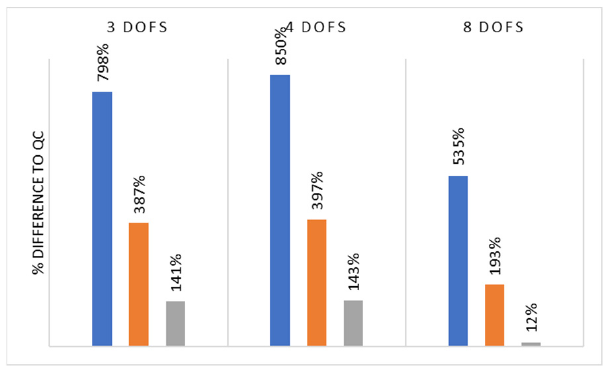
Figure 15. The percent difference in the RMS values of the acceleration of the top DOF of all models to the RMS values of the acceleration of the top DOF of the QC model for the periodic disturbance (blue = 5 km/h, orange = 10 km/h and grey = 15 km/h).